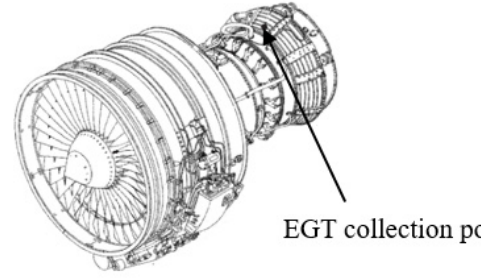
Figure 7. Aeroengine data sources.